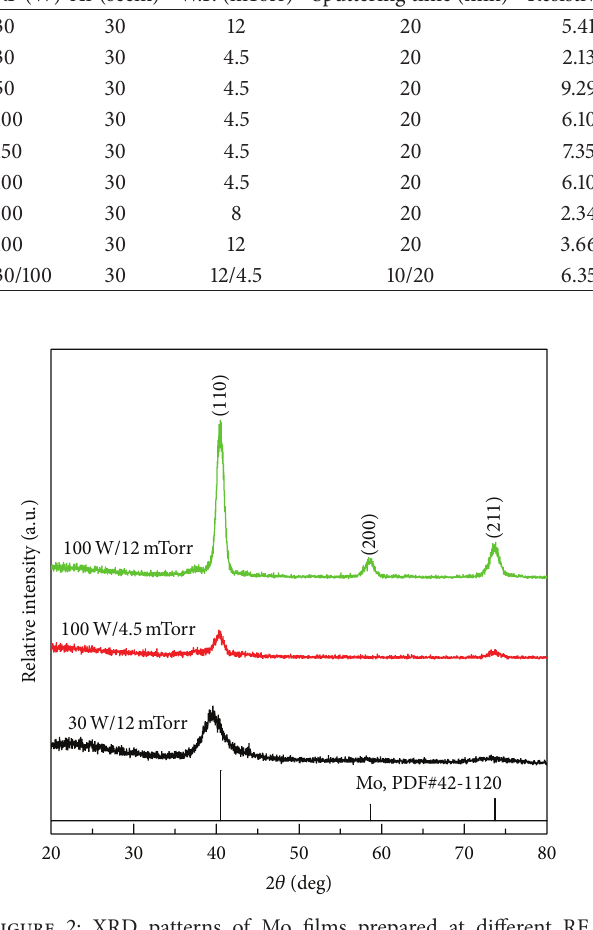
resistivity of the Mo film depended on the working pressure used. The electrical resistivities of the films grown at 8 and 12 mTorr decreased dramatically with escalating sputtering power. As the sputtering power rose from 50 to 100 W, the electrical resistivities, showing approximately an order in reduction, varied from 1.42 × 10 −3 to 1.16 × 10 −4 Ω -cm and from 1.52 × 10 −3 to 1.59 × 10 −4 Ω -cm, respectively, at